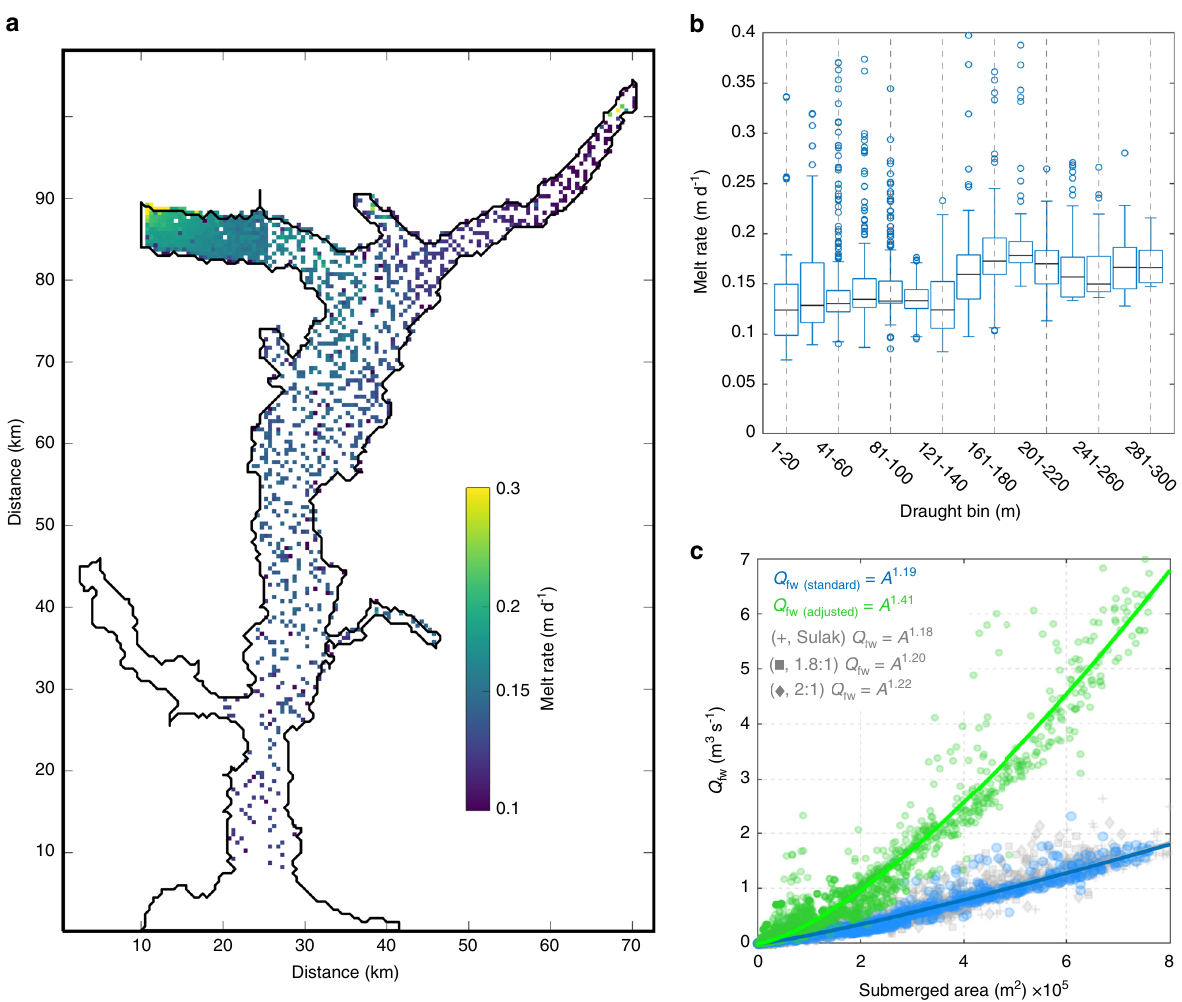
Fig. 3 Relationship between iceberg geometry and melt rates in our summer runoff forcing scenario. a Vertically-averaged submarine iceberg melt rates (note log scale). b Box plots showing vertically-averaged submarine melt rates of individual icebergs compared to iceberg draught. Each plot shows the median value (black line), interquartile range (box) and all other data (whiskers) except outliers (circles), with outliers de fi ned as data points more than 2.7 standard deviations from the median value. Vertical dashed grey lines in b are for visual aid. c Scatter plot of submerged iceberg area and freshwater fl ux ( Q fi ts (solid lines) and associated equations (where A is the submerged iceberg surface area). The blue fw ) from individual icebergs, with power-law and green coloured circles in c correspond to simulations with the standard and adjusted (Methods) melt rate parameter values respectively. The grey crosses, squares and diamonds in c correspond to simulations using the volume-area scaling of Sulak et al. 40 (Methods), and length to keel depth ratios of 1.8:1 and 2:1, respectively, all with the standard melt rate parameter values. Axis distances in a correspond to those in Fig.